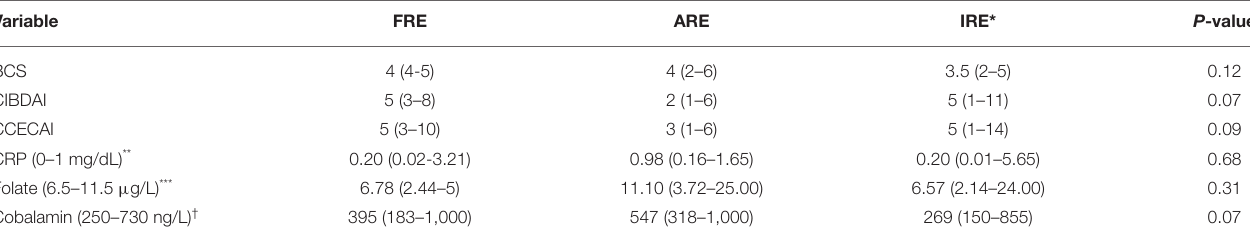
TABLE 2 | Median values, with minimum and maximum in brackets, of Body Condition Score (BCS), Canine Inflammatory Bowel Disease Activity Index (CIBDAI), Canine Chronic Enteropathy Clinical Activity Index (CCECAI), serum concentrations of C-reactive protein (CRP), folate and cobalamin in dogs with Food-responsive Enteropathy (FRE), Antibiotic-responsive Enteropathy (ARE), and Immunosuppressive-responsive enteropathy (IRE). Variable